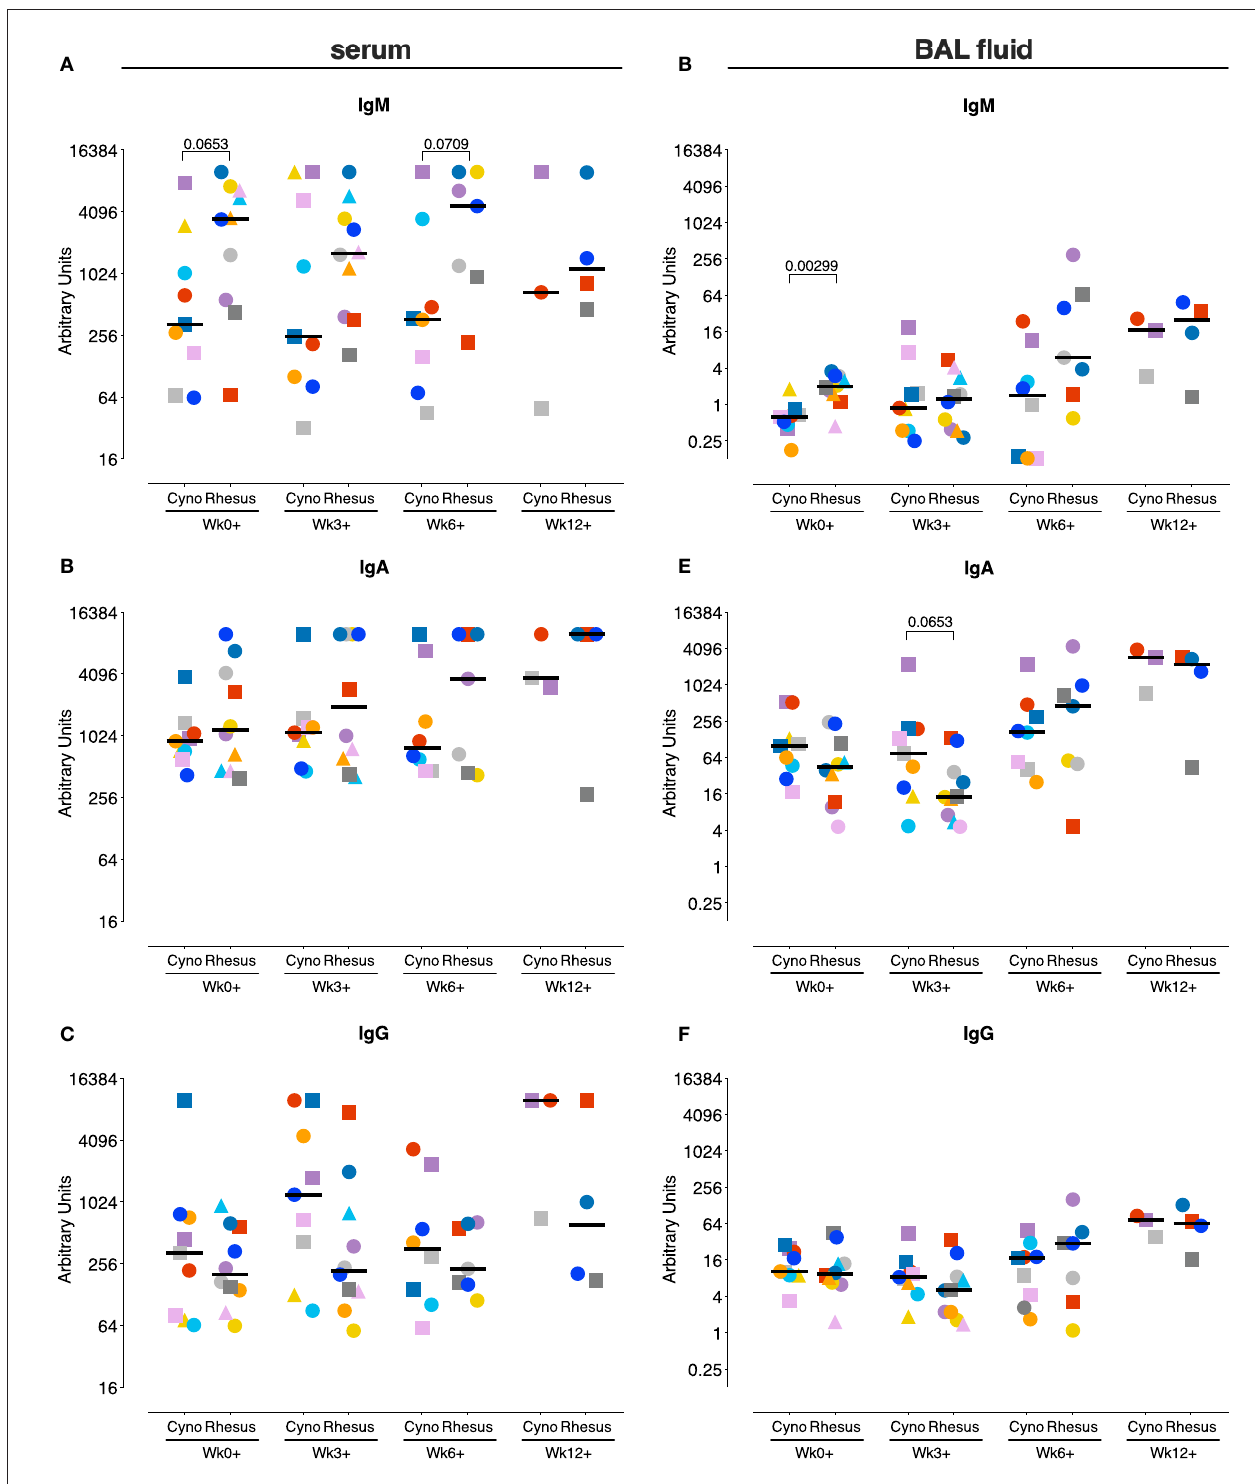
FIGURE 5 | Antigen-specific antibody levels after Mtb infection. Measurement of Mtb- specific IgM (A,D) , IgA (B,E) , and IgG (C,F) antibody response in serum (A–C) and BAL fluid (D,E) prior to and after Mtb infection. Antibody levels are plotted as arbitrary units, determined by standardization against a reference sample. Data are aligned to the moment of each individual’s time point of infection take. Number of animals per time point varies due to sample availability. Horizontal lines indicate group medians. Significance of group differences was determined by two-sided Mann-Whitney test. Color coding per individual, as defined in Table 1 , is consistently applied